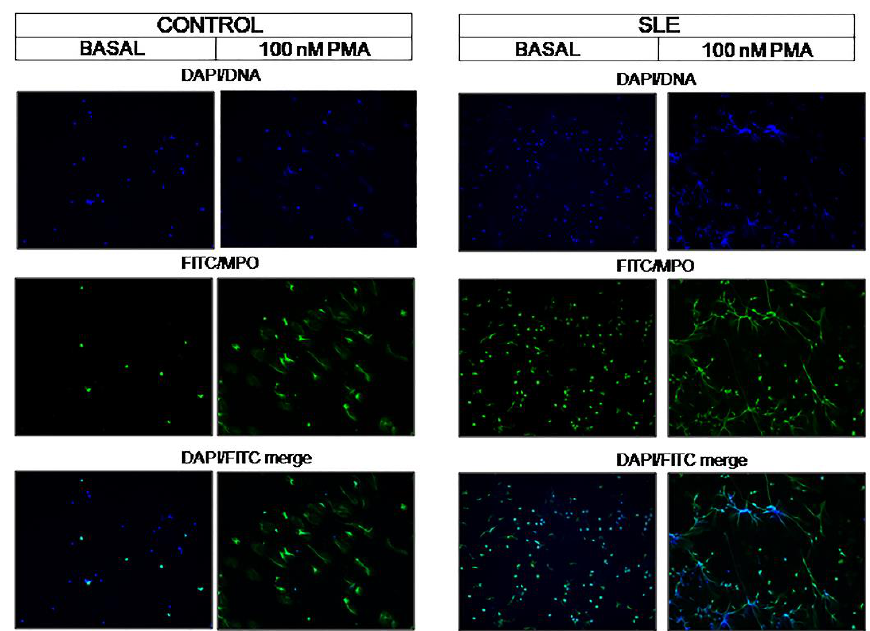
Figure 4. Formation of NETs.NETs were evaluated in basal conditions and after stimulation with 100 nMof PMA. DNA (DAPI, blue), neutrophil myeloperoxidase (MPO, FITC, green), and DAPI/FITC merge images areshown. Original magnification ×10.